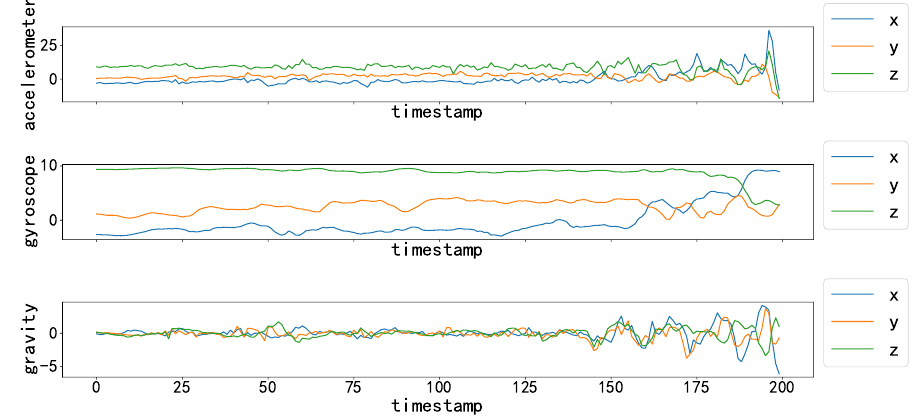
Figure 9. The triaxial data of accelerometer, gyroscope and gravity